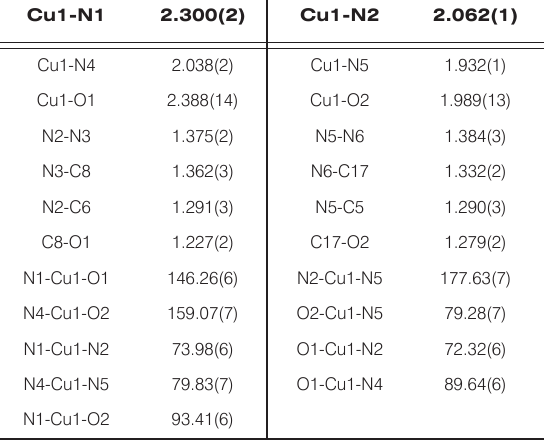
Table 2. Selected bond lengths [Å] and angles [ o ] for 1